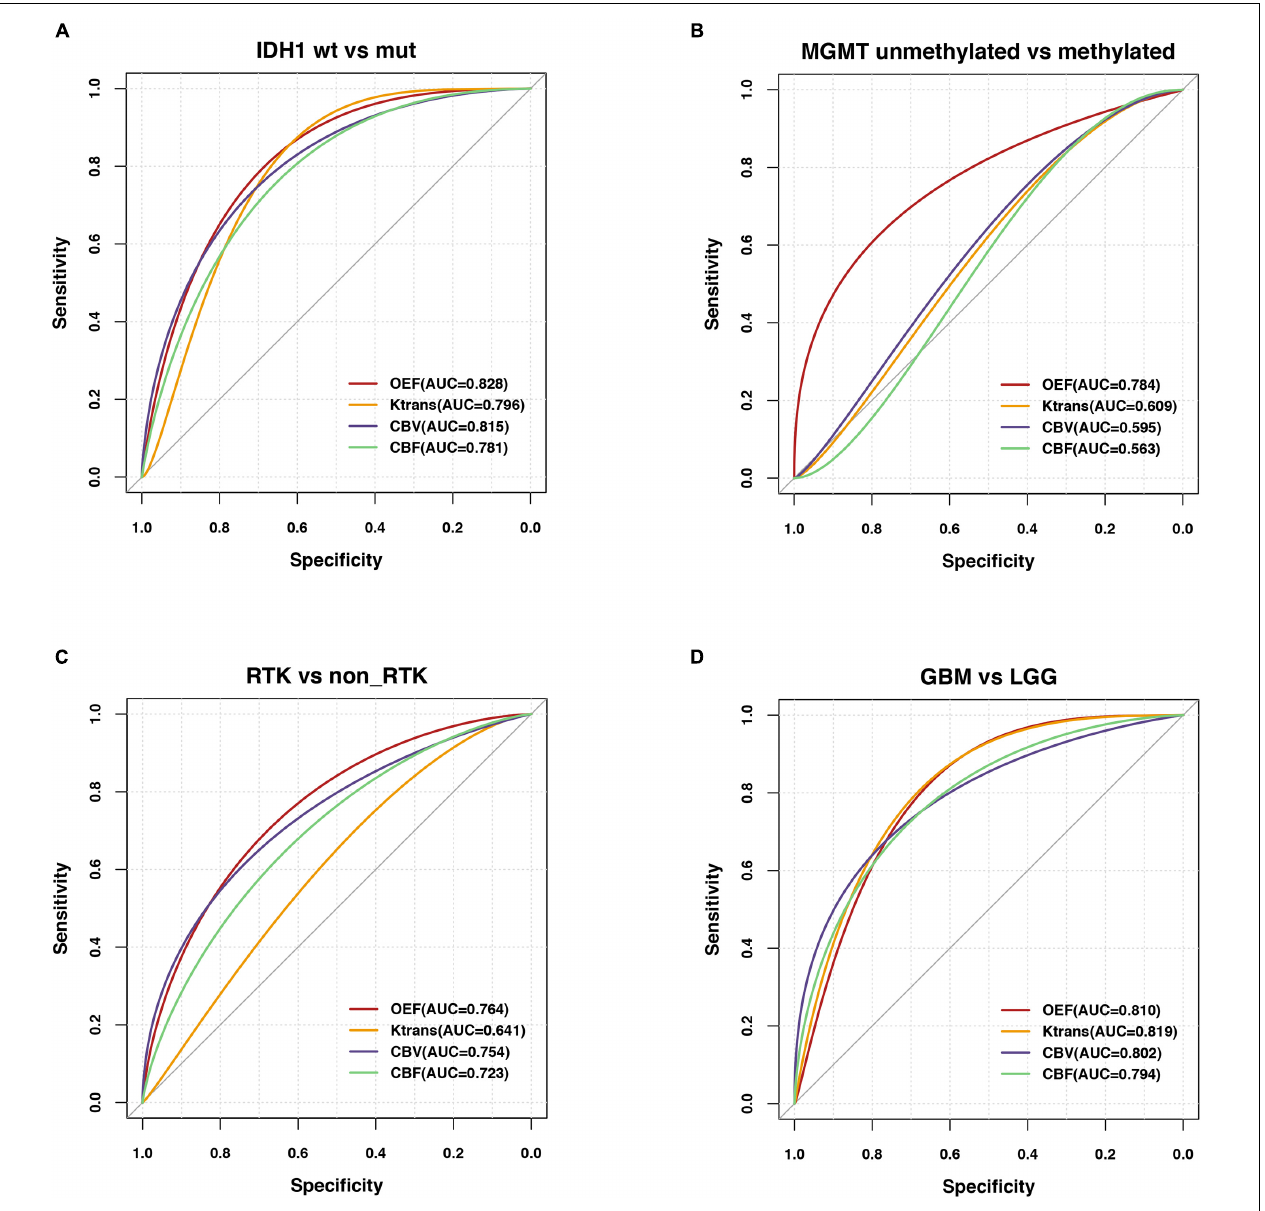
FIGURE 4 | Predictability of genetic profiles and WHO tumor grade in glioma patients. ROC analyses performed for OEF and vascular metrics in order to assess the contrast ability to predict (A) IDH mutation status in LGG (IDH 1 –R132H mutation vs. wild type), (B) MGMT promoter methylation status in GBM (methylated vs. unmethylated), (C) RTK subgroup in a subset of patients with NGS, and (D) WHO tumor grade (GBM vs.